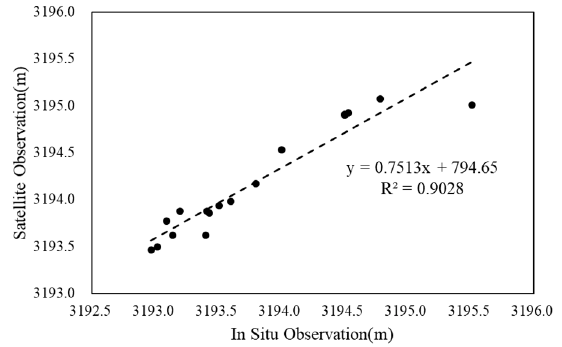
Figure 3. Correlation between in-situ water level observations and satellite altimetry observations (from Hydroweb and DAHITI) for Qinghai